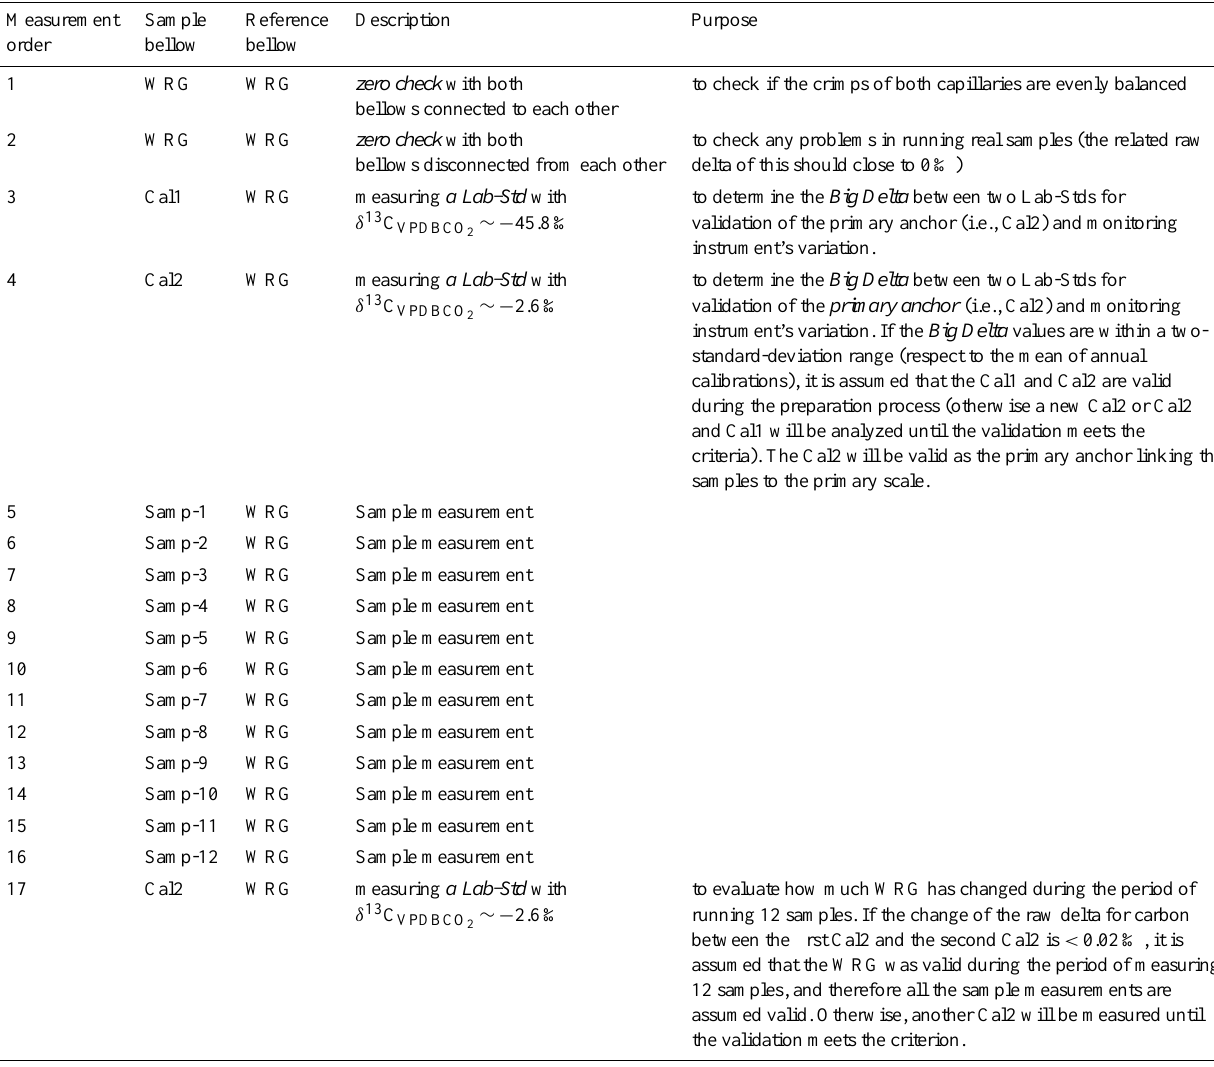
Table A2. Daily measurement ∗ sequence by IRMS (MAT252). Measurement Sample Reference Description Purpose order bellow bellow